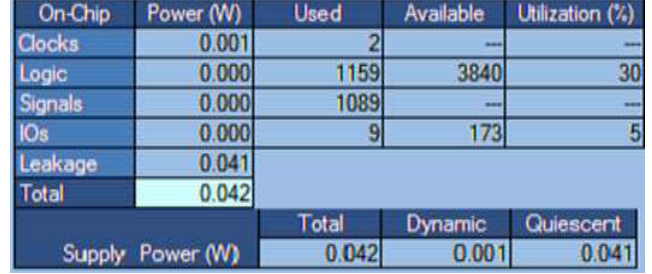
Figure 8. Estimated Power for 2x2 mesh NoC on FPGA